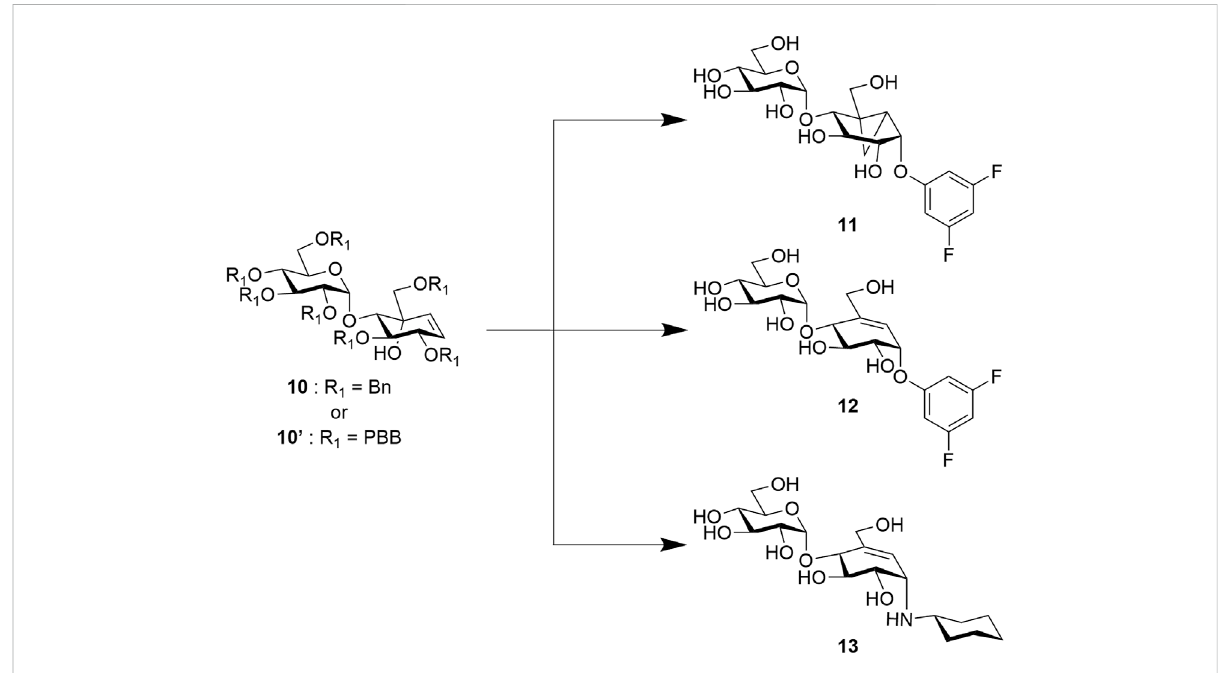
FIGURE 2 Proposed potential inhibitors 11 , 12 , and 13 from carbasugar intermediate 10